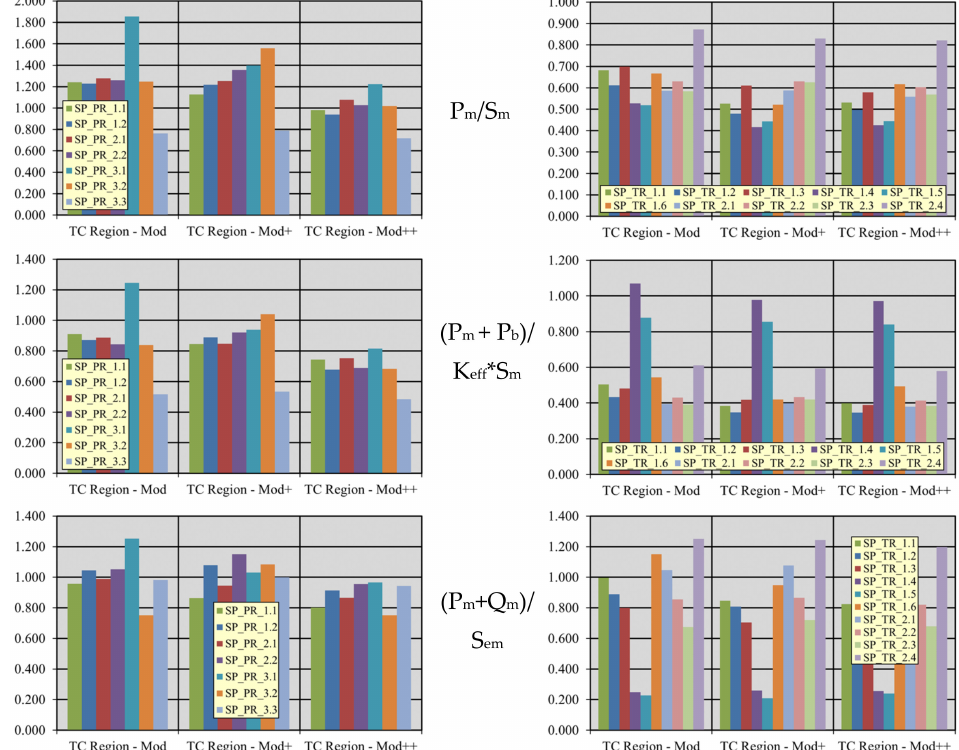
Figure 16. Trends of Level D criteria verification for